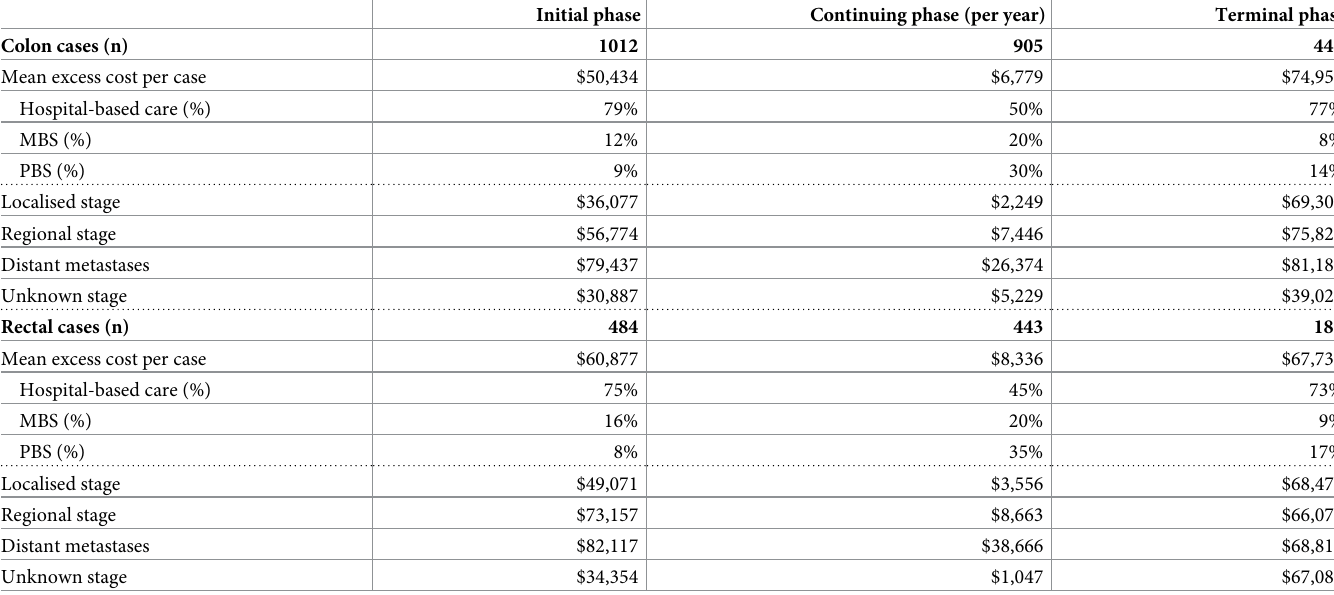
Table 2. Mean excess costs for colon and rectal cases diagnosed 2006–2013 in the 45 and Up Study, by phase of care, source of costs and disease stage.